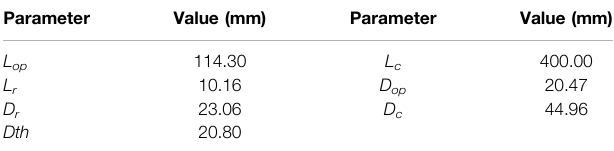
TABLE 1 | Key geometrical parameters of the single-element